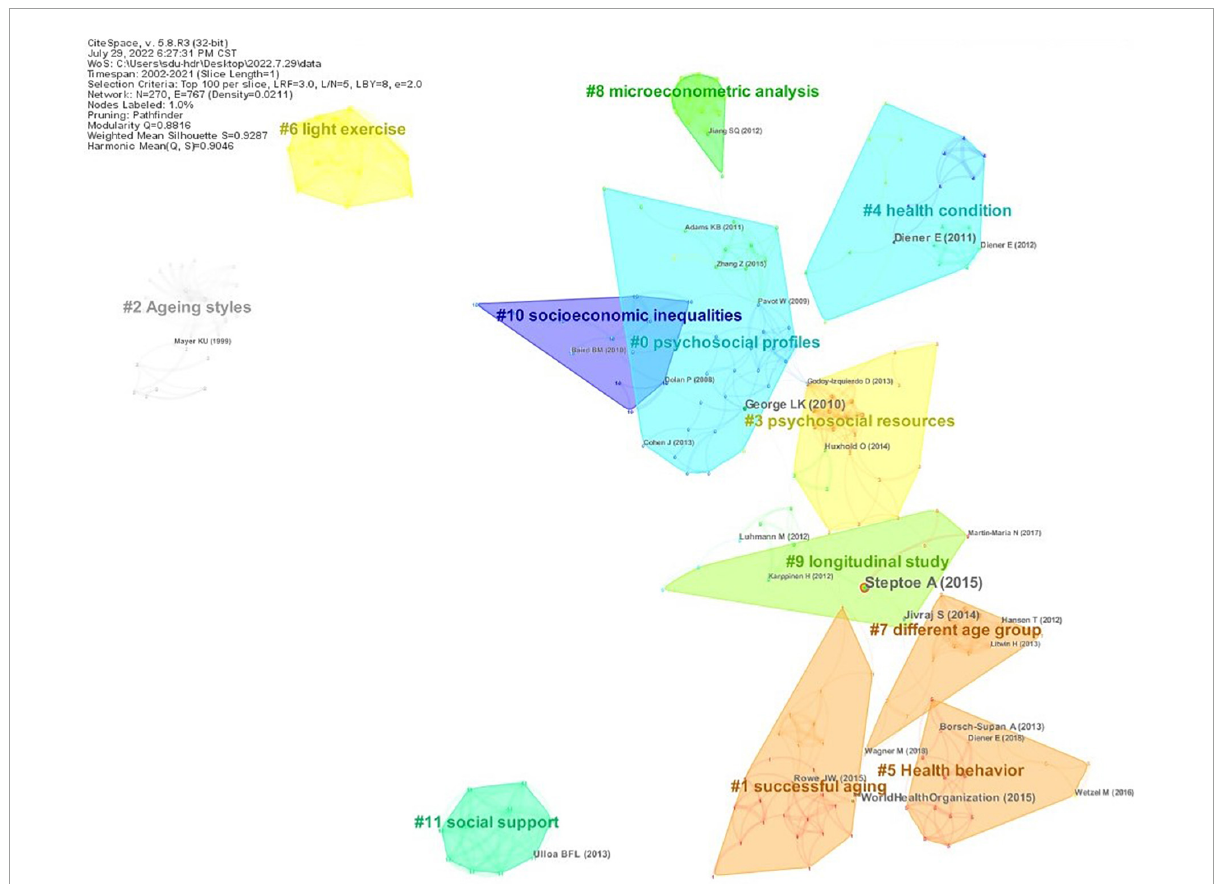
FIGURE7 Reference co-citation clusters. Each color block represents a cluster of co-cited references. The number of clusters is sorted according to the size of the color block (i.e, the number of references included in the